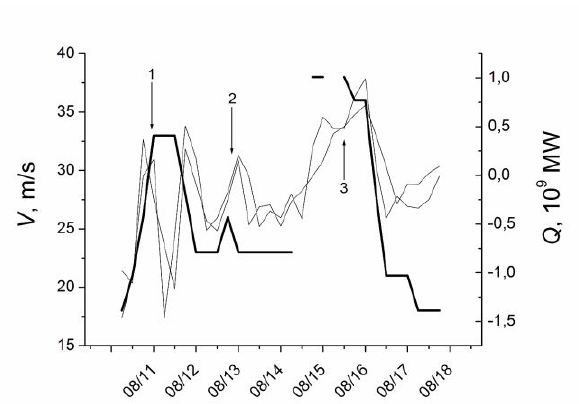
Figure 6. TC Ewiniar evolution, small contours for